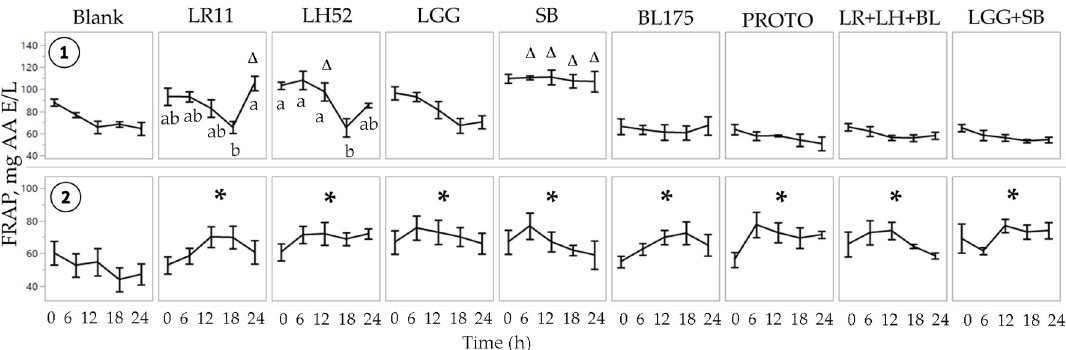
Figure 1. Antioxidant capacity of fecal water (FW) as measured by ferric reducing antioxidant power (FRAP). Normal FW C. difficile -infected FW. Values are shown as mean ± SEM. The symbol ∆ represents significant differences ( p < 0.05) between treatment at a particular time point and blank at the corresponding time point. The symbol * represents significant differences between treatment and blank ( p < 0.05) when the means of all time points are jointly considered. Means at time points within treatments without a common letter are significantly different ( p < 0.05). LR11 = L. rhamnosus R0011; LH52 = L. helveticus R0052; LGG = L. rhamnosus GG; SB = S. boulardii ; BL175 = B. longum R0175;